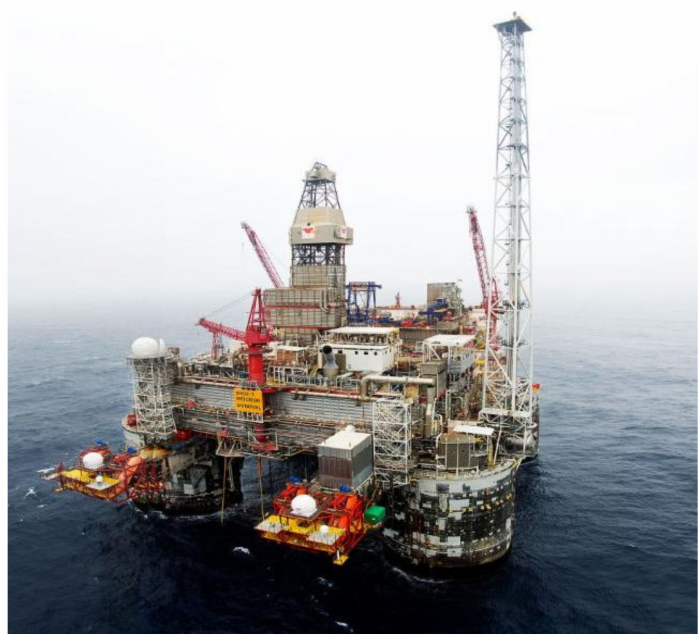
Figure 17. Heidrun Tension Leg Platform (TLP). (Courtesy: